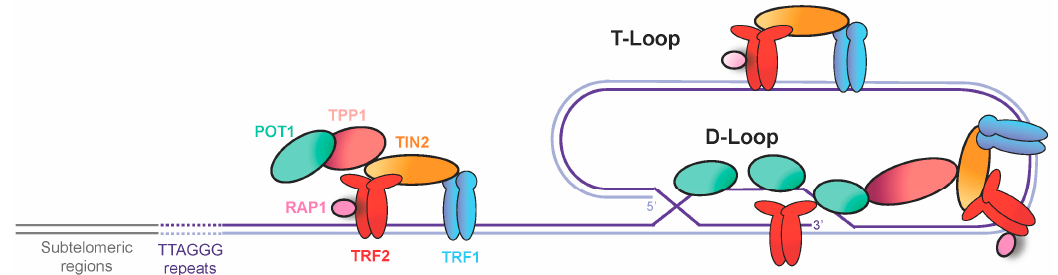
Figure 1. The vertebrate shelterin complex. Telomeric repeat binding factors 1 and 2 (TRF1 and TRF2) bind to double-stranded telomeric DNA and recruit other components of shelterin: TRF1-interacting nuclear protein 2 (TIN2), the human ortholog of the yeast repressor/activator protein 1 (RAP1), and tripeptidyl peptidase 1 (TPP1). Protection of telomeres 1 (POT1) protein binds to the telomeric single-stranded DNA. Shelterin promotes the fold-back of telomeric DNA into a T-loop structure through formation of a D-loop.